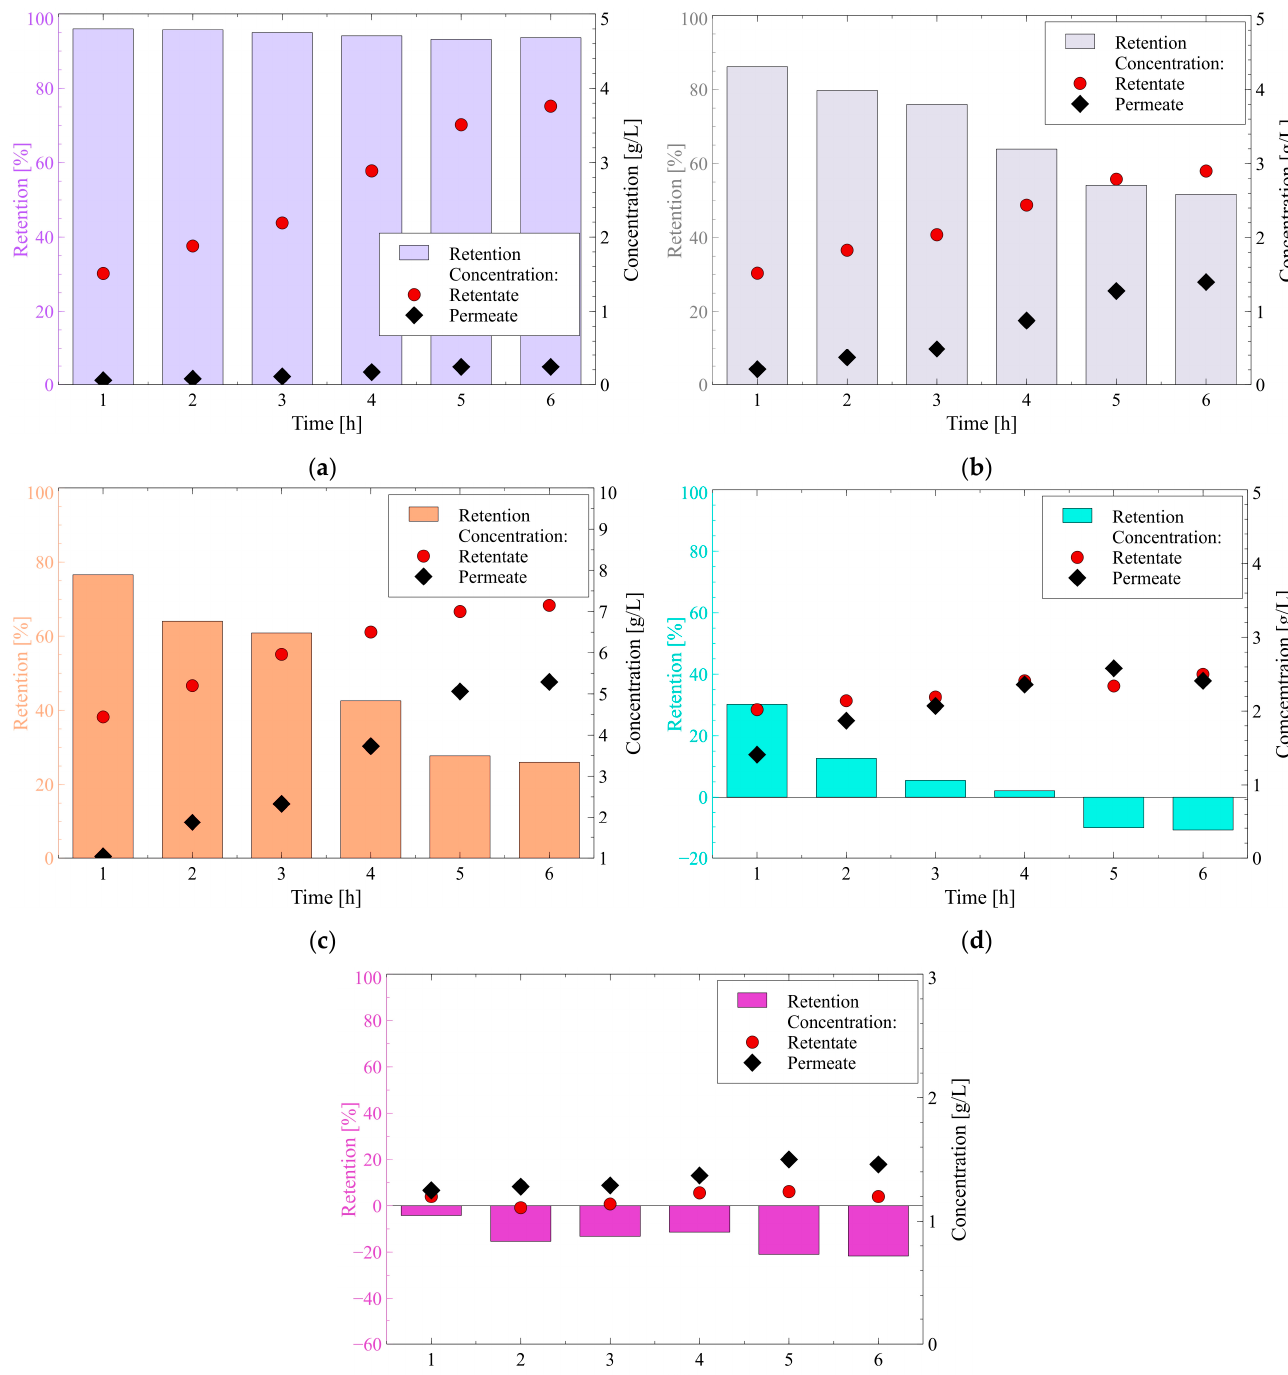
Figure 8. Changes in retention and concentration of the main by-products during the NF process of fermentation broth: ( a ) Succinic acid; ( b ) Lactic acid; ( c ) Acetic acid; ( d ) Formic acid; ( e ) Ethanol. TMP = 1.4 MPa, T = 298 K.